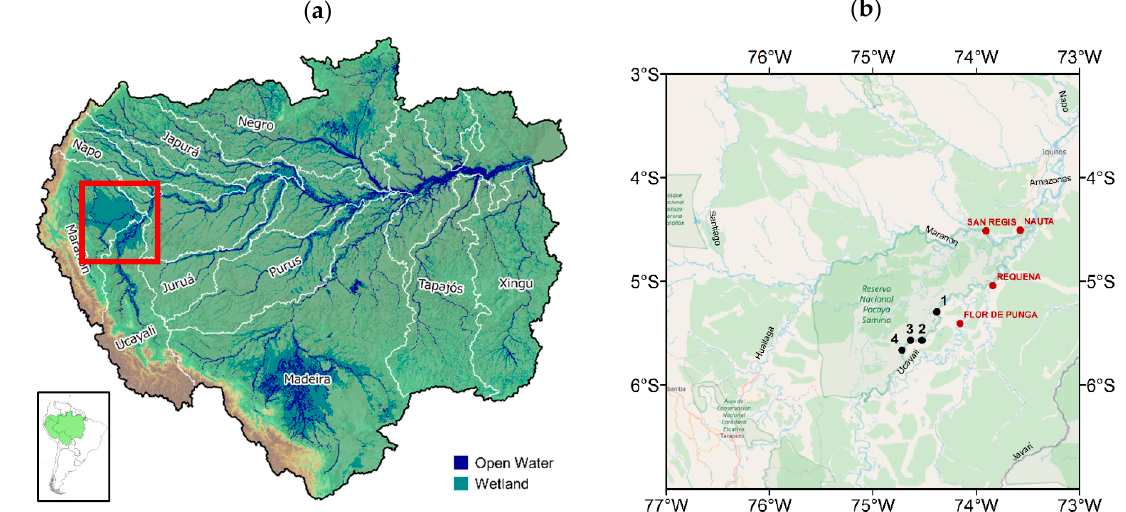
Figure 1. ( a ) The Amazon Basin, illustrating primary river sub-basins and freshwater ecosystem extent, with the study region boxed in red. Data sources: open water and wetland delineation from Reference [31]; sub-basin boundaries and GTOPO30 digital elevation model (DEM) from Reference [32]; ( b ) Extent of the study area, bounded by 3–7°S, 73–77°W, containing the Pacaya Samiria National Reserve. Locations of biometry measurement sites 1–4 along Canal de Puinahua are labelled in black. Field station location where river gauge data are available are shown in red.